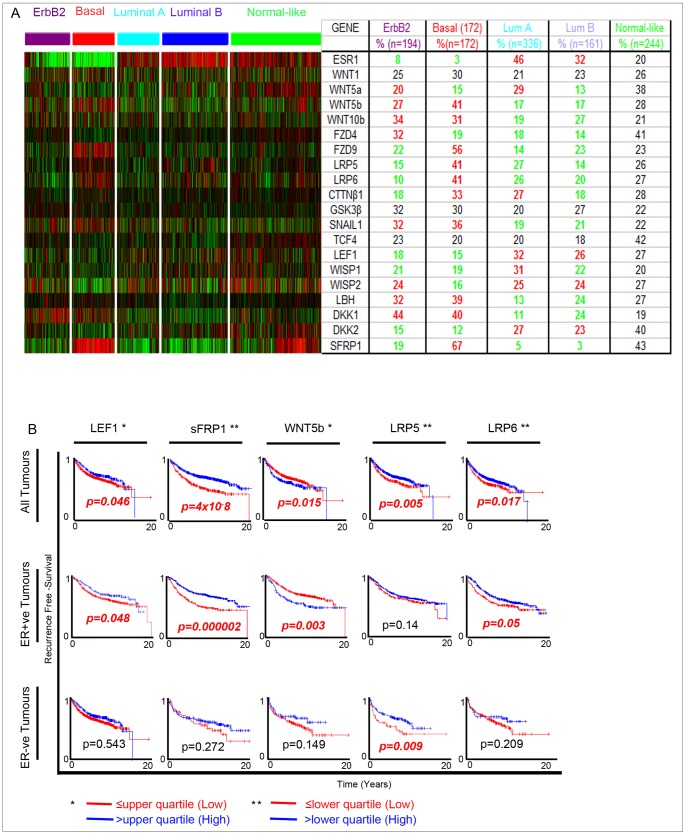
Analysis of mRNA expression in primary human breast cancer samples.Expression data was combined from multiple studies into a combined cohort of ERBB2 (n = 194) Basal (172) Luminal A (n = 336) and Luminal B (161) and normal-like (n = 244) subtypes of breast cancer. A) mRNA expression data was displayed in a heatmap: decreased (green) or increased (red) expression compared to the mean mRNA expression. % of samples with high gene expression are detailed and denoted as green when expression is decreased and red when expression is increased. B) Kaplan Meier plots Wnt gene expression show the years of recurrence free survival, where red indicates lower gene expression and blue indicates higher gene expression. * Red ≤upper quartile: Blue >upper quartile ** Red ≤lower quartile: Blue >lower quartile. P values were generated and significant results were highlighted in red.